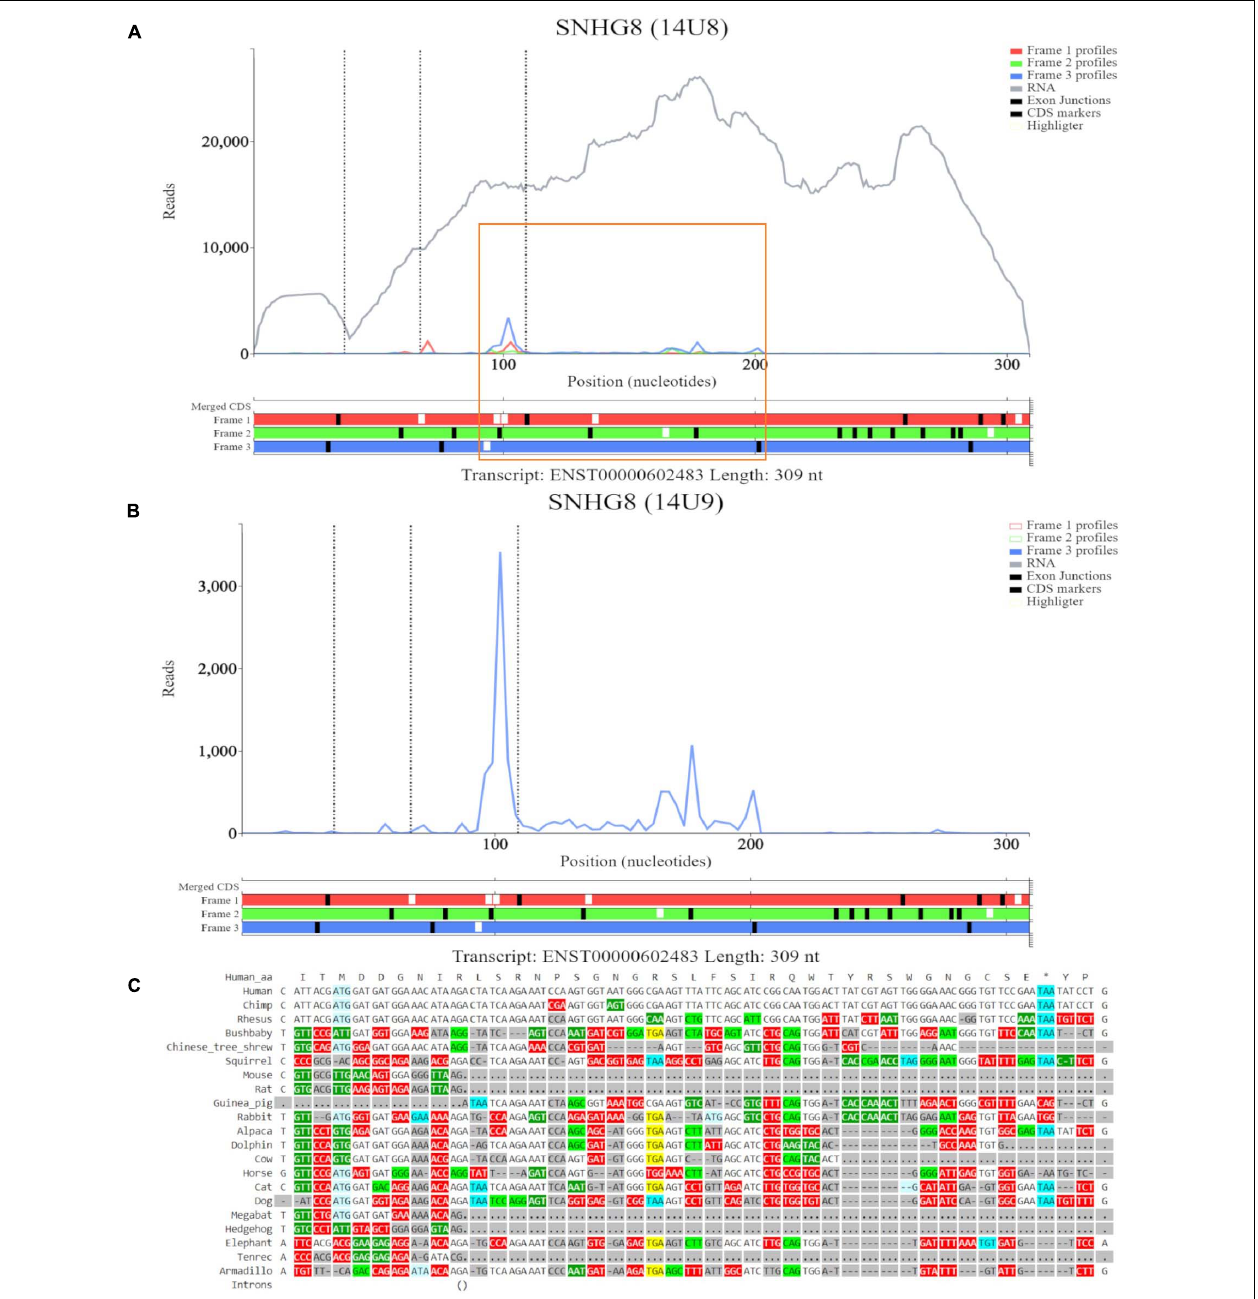
FIGURE 5 | Visualization of SNHG8 in Trips-Viz and CodAlignView. (A) Visualization of SNHG8 isoform ENST00000602483 in Trips-viz. The ORF previously outlined in orange in GWIPS-viz is similarly outlined again. (B) Visualization of transcript ENST00000602483 without RNA-seq data enabled and only reading frame 3 enabled. (C) CodAlignView for the ORF previously outlined in orange showing a high ratio of radical non-synonymous codon